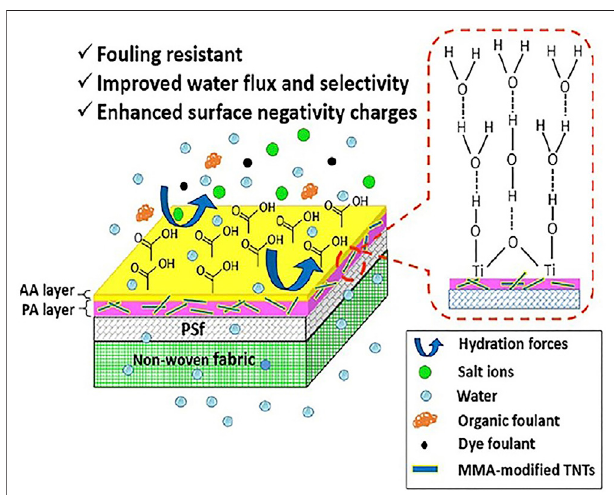
FIGURE 6 | Improved antifouling behaviour through AA-modi fi ed TFN membrane (Siew Khoo et al., 2021).